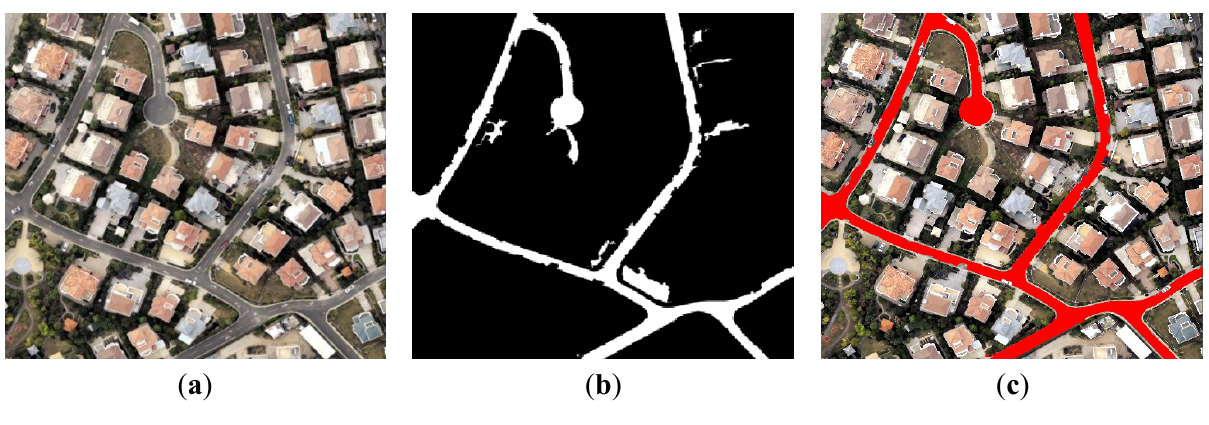
Figure 4. Road extraction. ( a ) The test image, which is an urban image without damage; ( b ) The hypothetic roads; ( c ) The roads after